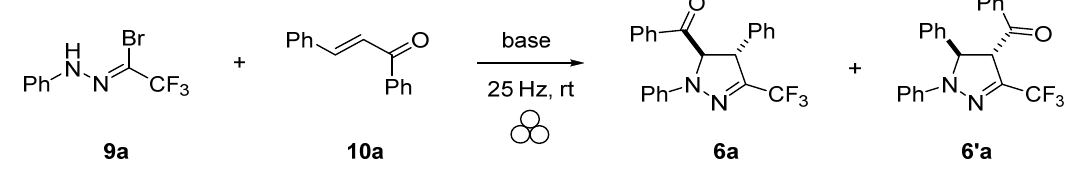
Table 1. Optimization of (3 + 2)-cycloaddition reaction of 9a and 10a .